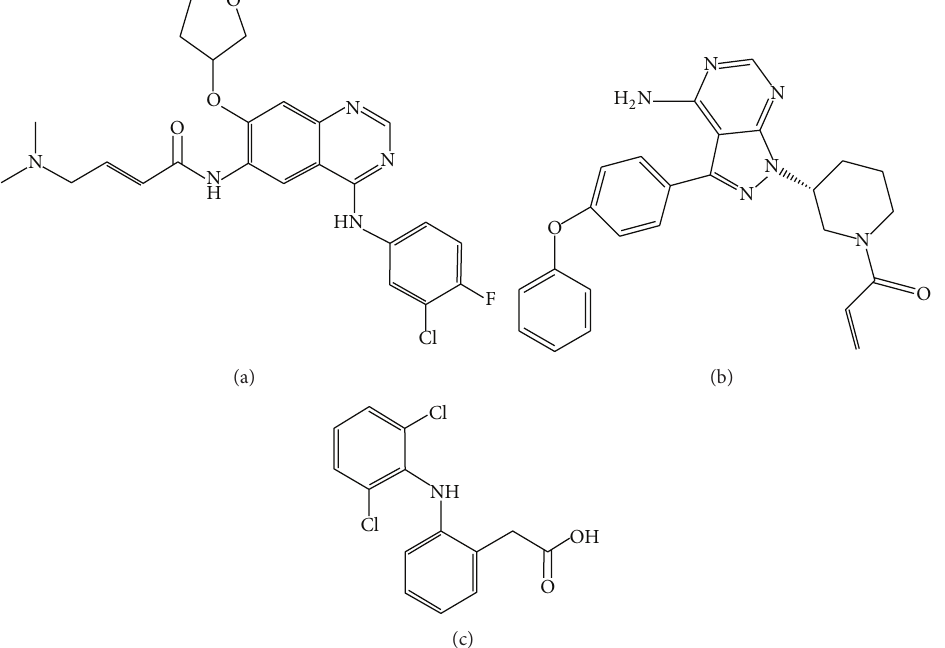
Figure 1: Chemical structures of (a) afatinib, (b) ibrutinib, and (c)